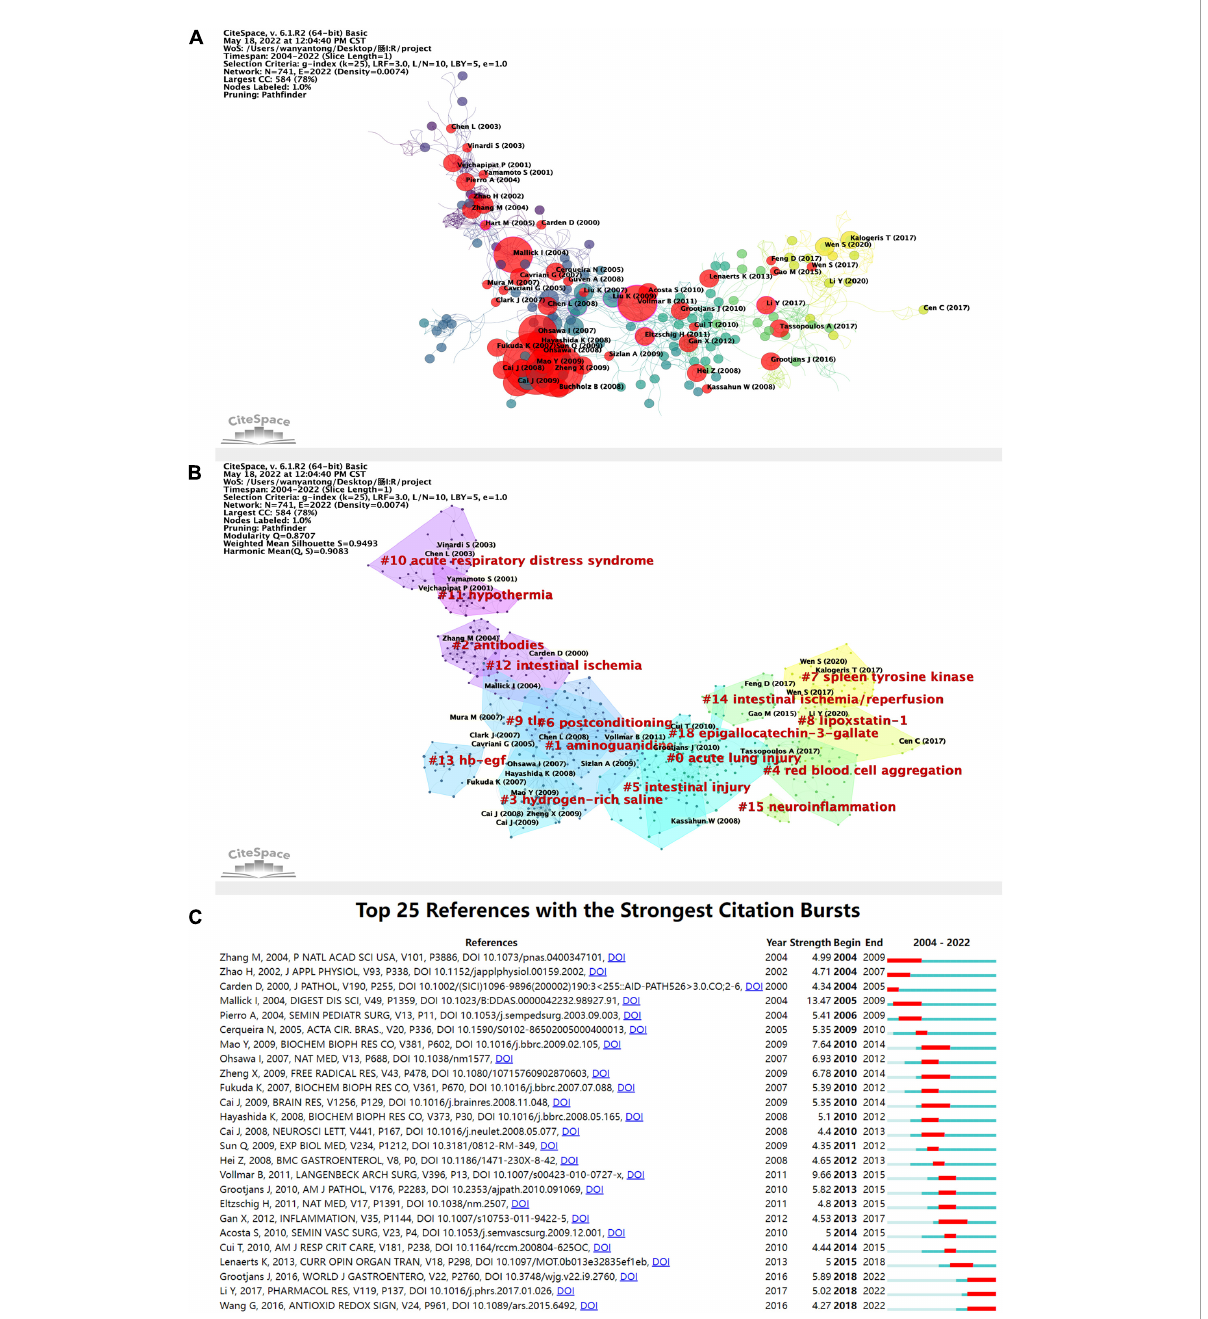
FIGURE7 (A) Application of CiteSpace, literature relationship network diagram. The different colors of the nodes represent additional years, from purple to yellow, the later the time. In addition, the red nodes represent literature with citation burst. The node size represents the citation frequency. (B) Clustering of the literature in the literature relationship network graph, with a total of 17 clusters. (C) Top 25 high burst of cited literature. The blue line indicates the timeline, and the red phase represents the outbreak period. It is based on the burst test to detect sudden changes in information like documents and keywords. In CiteSpace, the burst test is developed by Kleinberg J. The meanings of the burst test represent a sharp increase in document citations and some critical questions in the field proposed or solved in the documents.